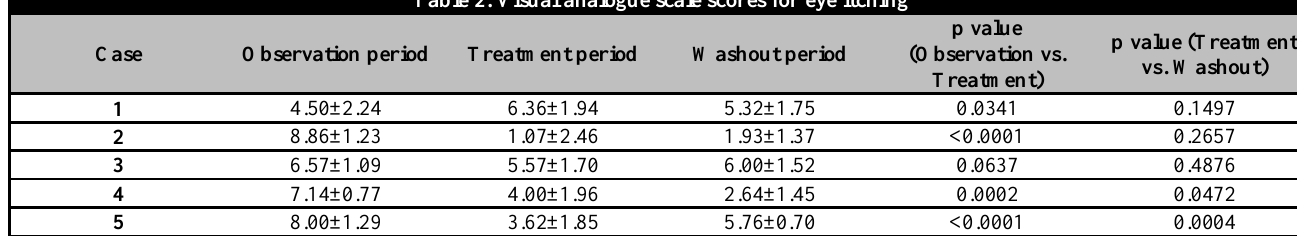
Table 2. Visual analogue scale scores for eye itching